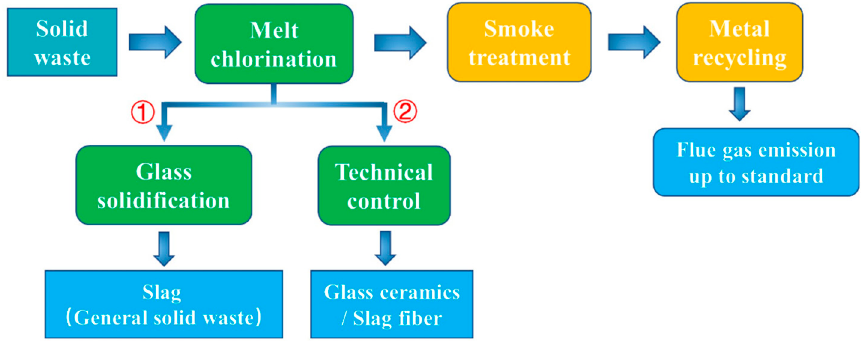
Figure 1. A novel process for harmless disposal of solid waste containing chlorine.